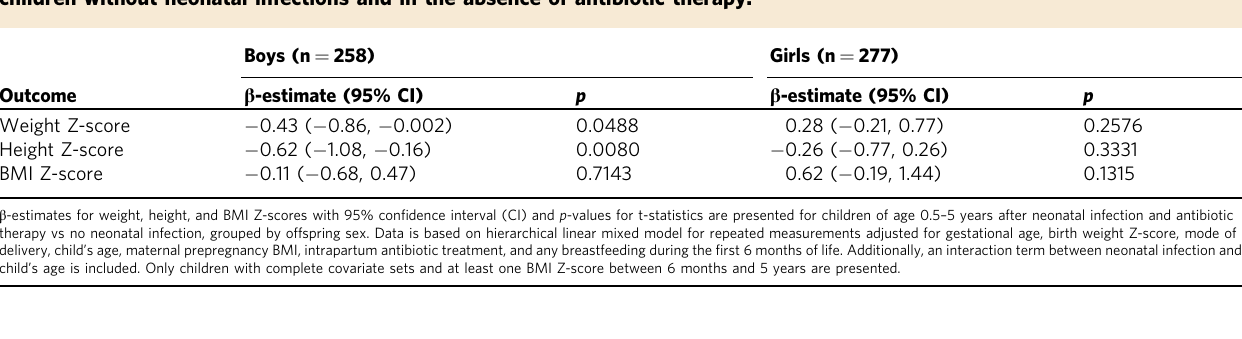
Table 2 Weight, height and body mass index (BMI) Z-scores during the fi rst fi ve years of life in children of the Programming of Enhanced Adiposity Risk in Childhood – Early Screening (PEACHES) cohort with neonatal infection and antibiotic therapy vs. children without neonatal infections and in the absence of antibiotic therapy. Boys (n = 258) Girls (n = 277) Outcome β -estimate (95% CI) p β -estimate (95% CI) p Weight Z-score − 0.43 ( − 0.86, − 0.002)